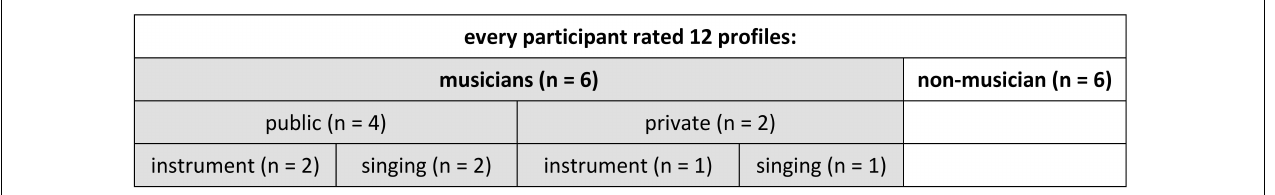
FIGURE 1 | Nesting of profiles rated by